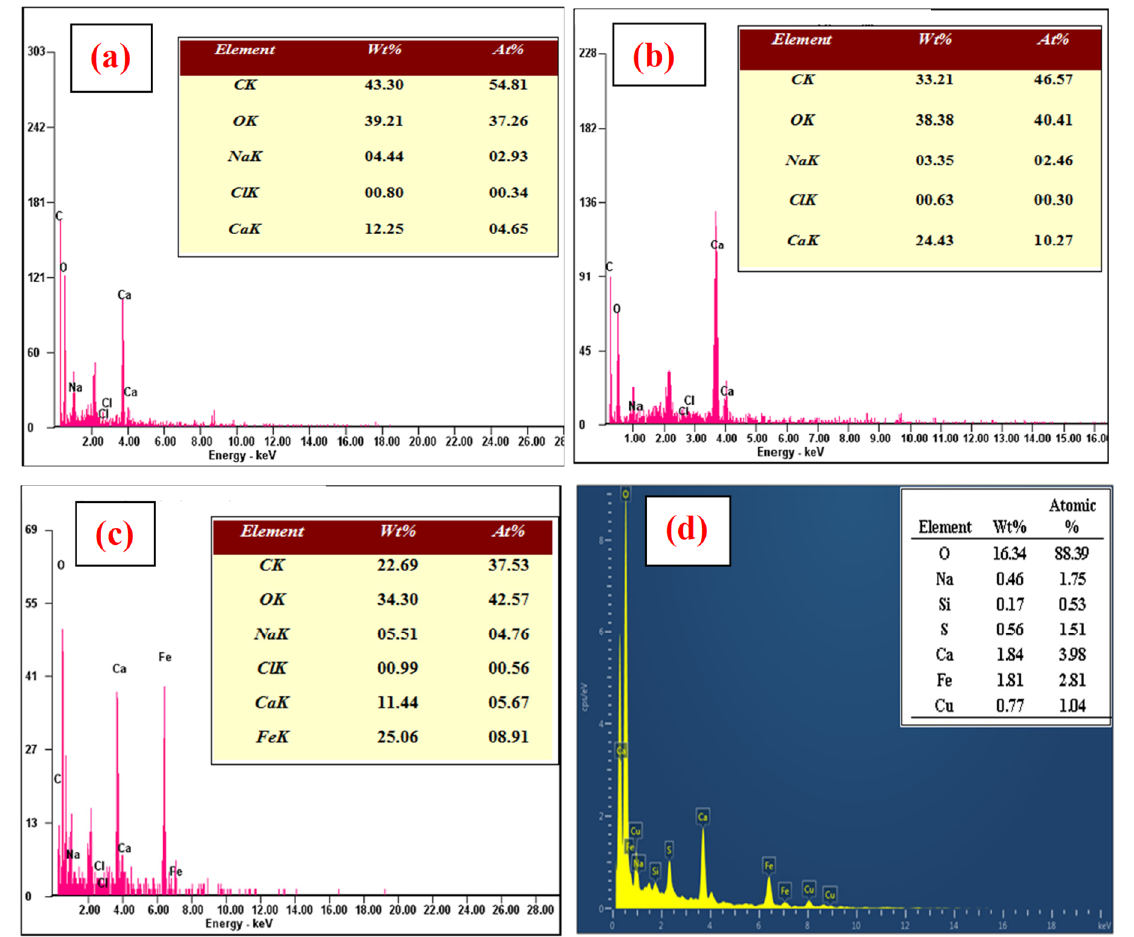
Figure 7. EDX spectra of ( a ) CABs, ( b ) AVCABs, and ( c ) AVMNCABs before adsorption; and ( d ) AVMNCABs after adsorption.